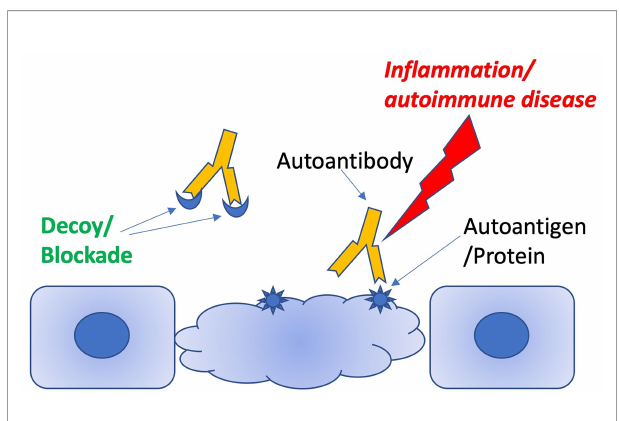
FIGURE 1 | Schematic illustrating how decoy peptides can distract pathogenic antibodies from targeting